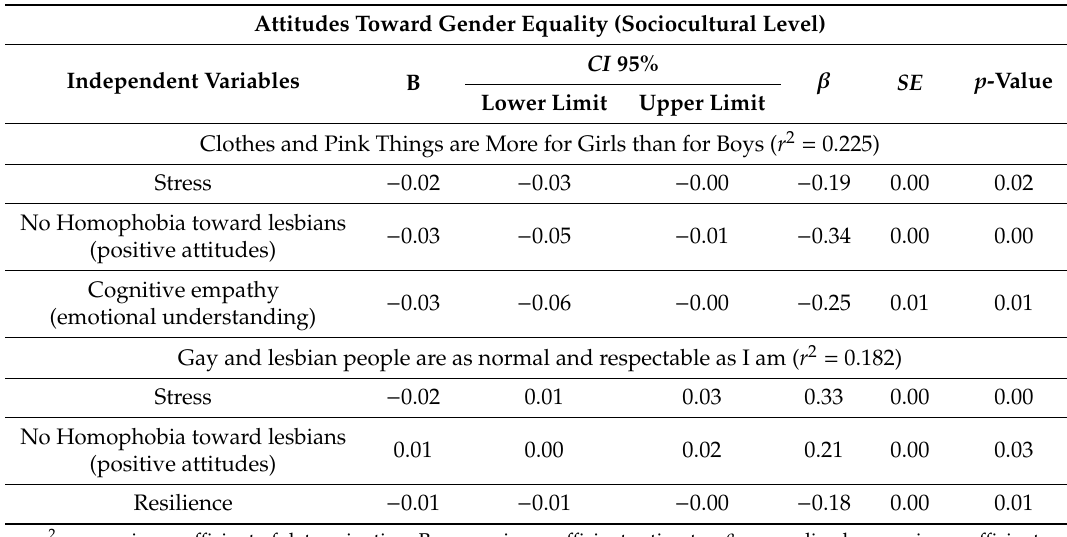
Table 5. Regression of “attitudes toward gender equality” (statistically significant items at sociocultural level) for the variables homophobia toward gays and lesbians, self-esteem, emotional intelligence, empathy, levels of everyday stress, and resilience in university students.